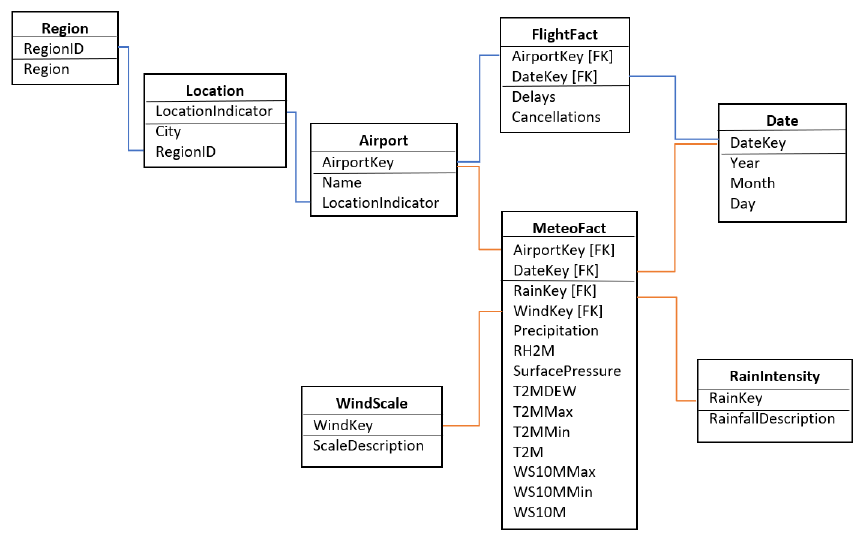
Figure 2. The hybrid schema of the MeteoFlight DW model.